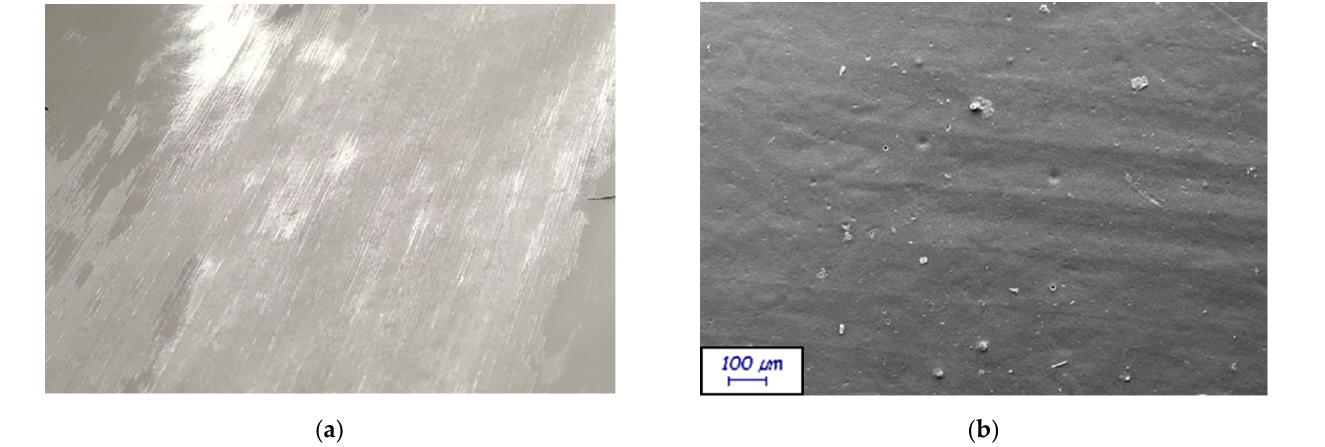
Figure 2. ( a ) H39K 100 coating over KP substrate after drying: grooves affect the aesthetical and perceptive properties of the coated sample; ( b ) SEM micrograph (magnification: 250×) showing the grooves at a larger scale. ImageJ processing shows peak distance of around 150 μ m.